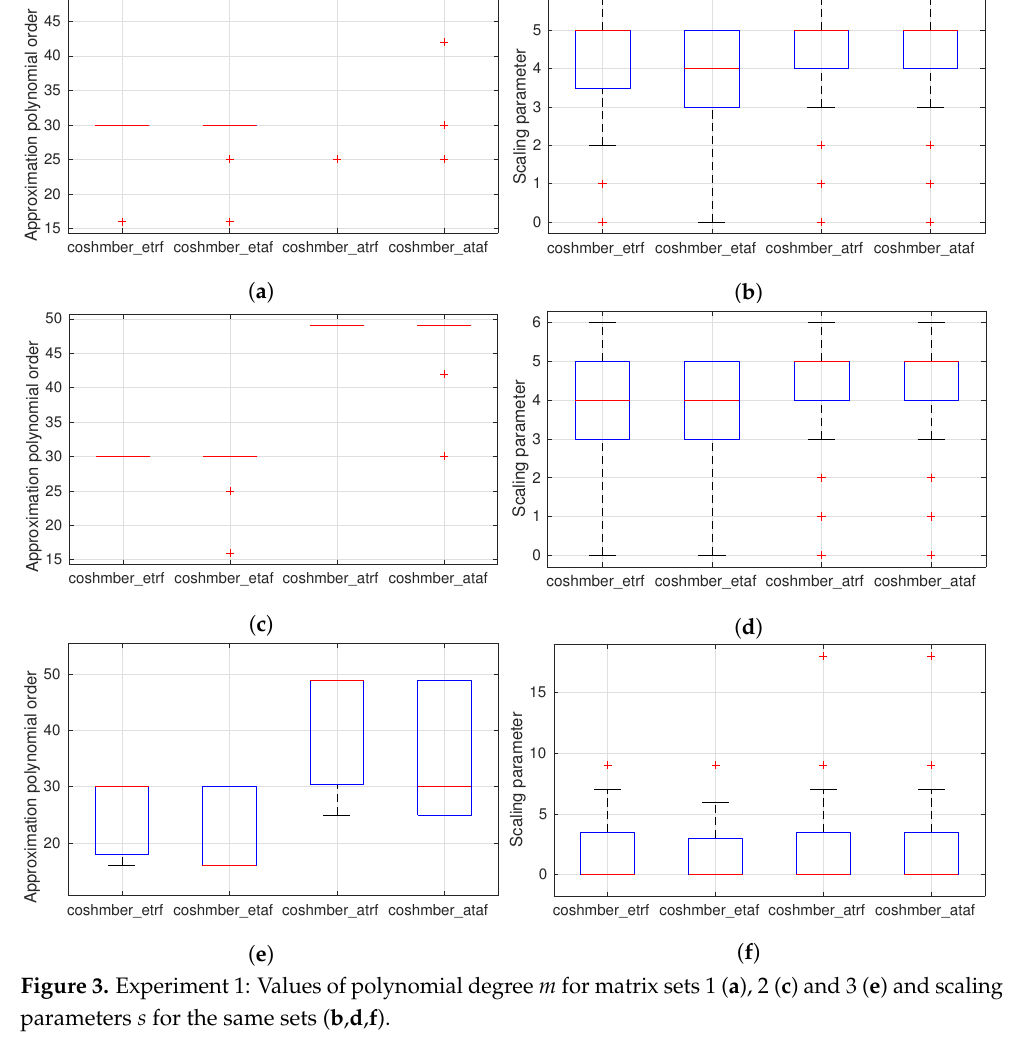
Figure 3. Experiment 1: Values of polynomial degree m for matrix sets 1 ( a ), 2 ( c ) and 3 ( e ) and scaling parameters s for the same sets ( b , d , f